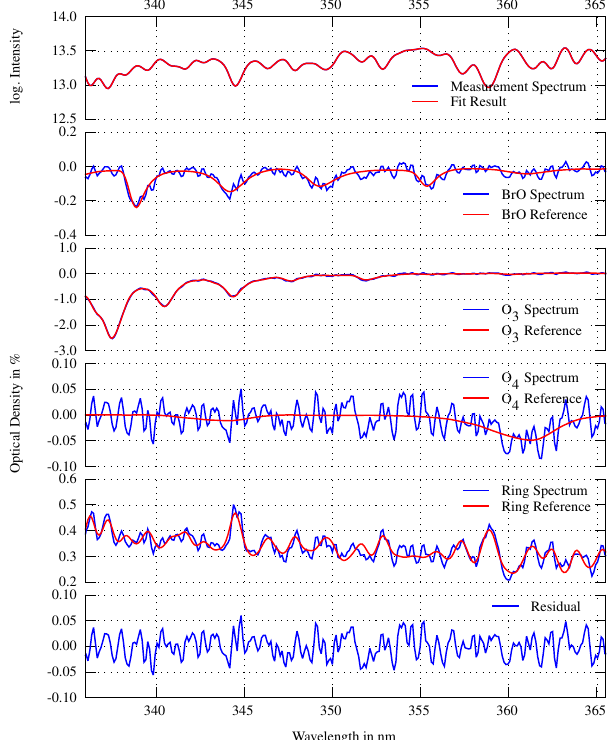
Figure 12. Sample BrO fit (dSCD ≈ 1.6 × 10 14 moleccm − 2 ) of a nadir measurement taken from the flight to Prudhoe Bay on 31 March 2012 at 02:05UTC. The red line shows the fitted ab- sorption structure whereas the blue line shows the fit result plus the residual.